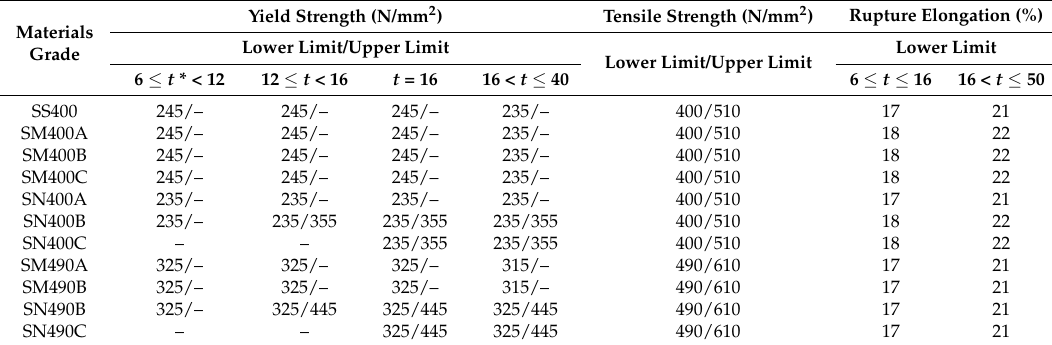
Table 3. Mechanical properties (JIS